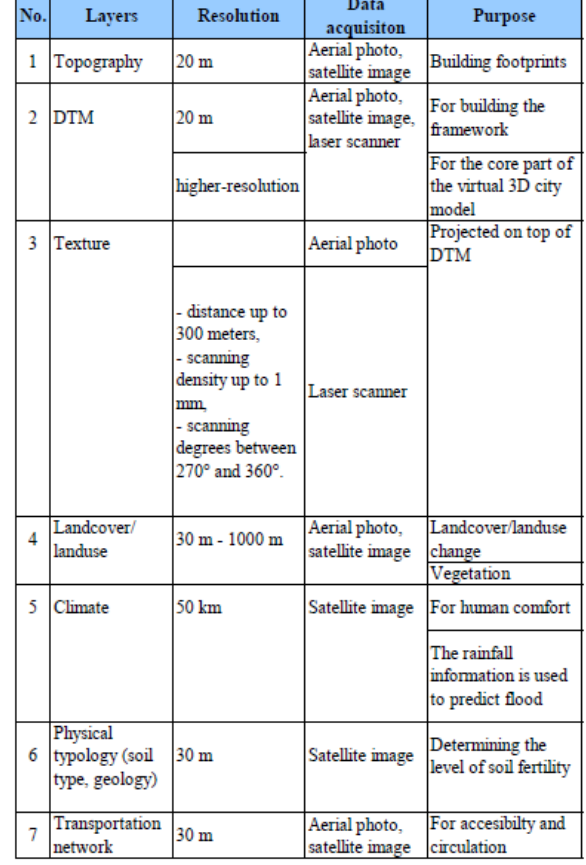
Figure 4 A workflow scheme of methods used in Sadek et al. Project (Sadek et al.,